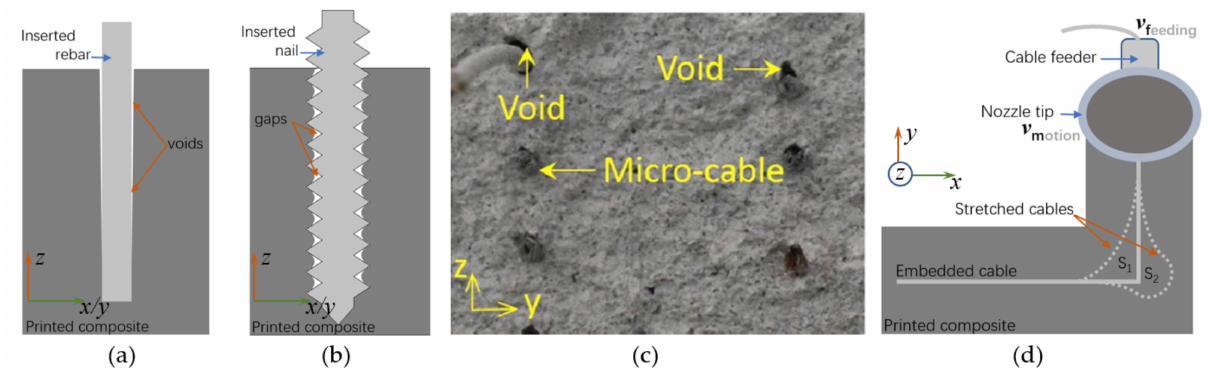
Figure 12. The issues exist in the reinforcing techniques. ( a ) voids occurred around the inserted rebars, ( b ) gaps in the threading nail not completely filled, ( c ) voids around the embedded long cable (reprinted with permission from ref. [16]), and ( d ) stretched cables create bad contacting area S 1 /S 2 between two adjacent